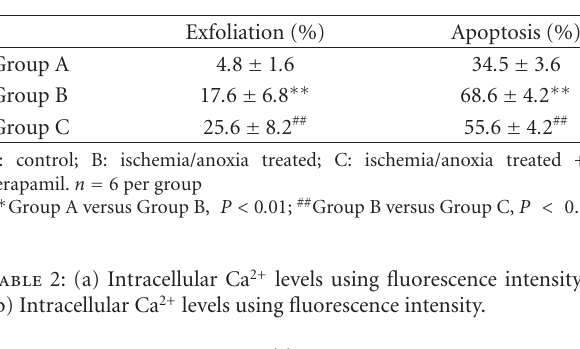
Table 1: Extent of exfoliation and apoptosis.